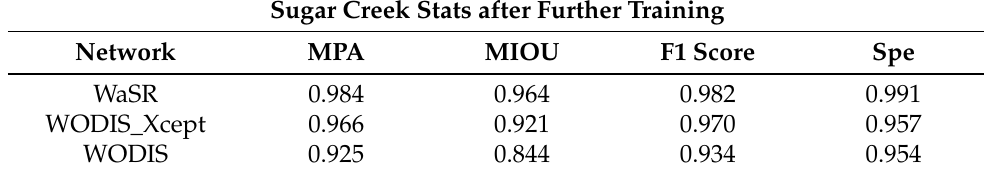
Table 5. Quantitative capability of networks on segmenting the Sugar Creek subset of ROSEBUD after training on the Wabash River subset for the number of epochs as summarized in Table